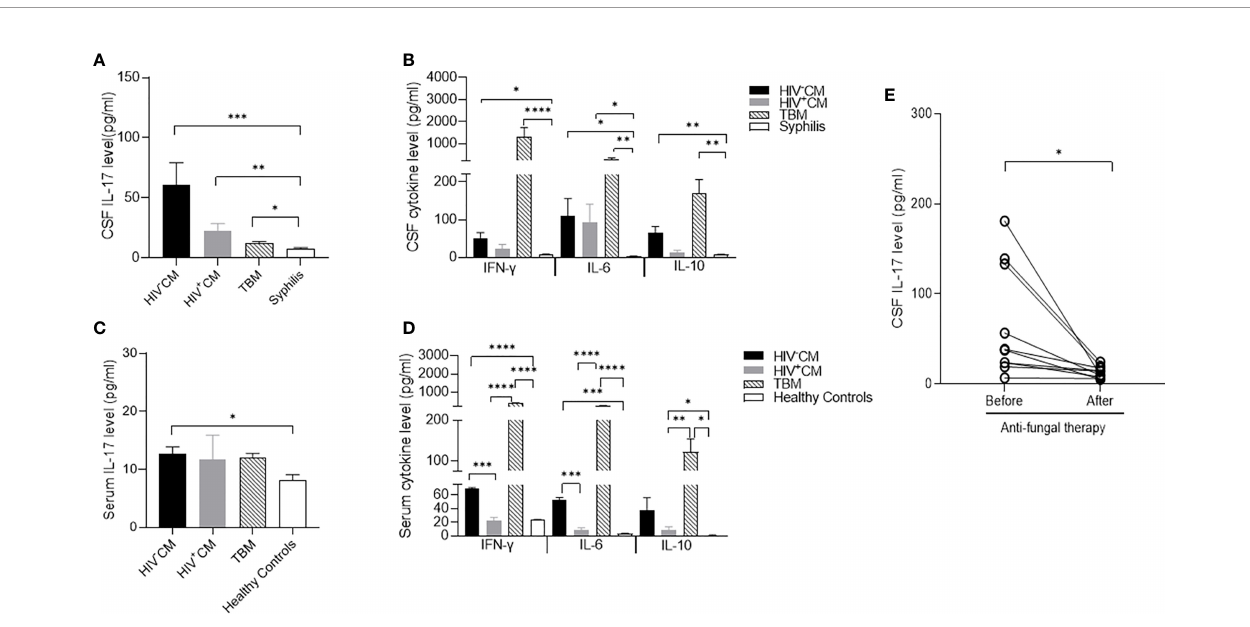
FIGURE 1 | Cytokine levels of cerebrospinal fl uid (CSF) and serum in patients with C. neoformans and tuberculosis meningitis. CSF was collected before and at about 3 months after the pathogen-speci fi c therapies, while serum samples were collected on admission. The cytokine levels were measured by ELISA. (A) CSF levels of IL-17 in non-HIV CM ( n = 11), HIV-positive CM ( n = 5), TBM ( n = 15), and syphilis ( n = 9) on admission. (B) CSF levels of IFN- g , IL-10, and IL-6 in non-HIV CM ( n = 11), HIV-positive CM ( n = 5), TBM ( n = 15), and syphilis ( n = 9) on admission. Serum levels of IL-17 (C) and IFN- g , IL-10, and IL-6 (D) in healthy controls ( n = 3), non-HIV CM ( n = 4), HIV- positive CM ( n = 5), and TBM ( n = 4) at admission. (E) Changes of CSF levels of IL-17 in non-HIV CM ( n = 11) and TBM ( n = 15) before and after pathogen-speci fi c therapies. Statistical signi fi cance was indicated as * p < 0.05, ** p < 0.01, *** p < 0.001, **** p < 0.0001. Data are shown as mean ± SE of the samples. CM, C. neoformans meningitis; TBM, tuberculous